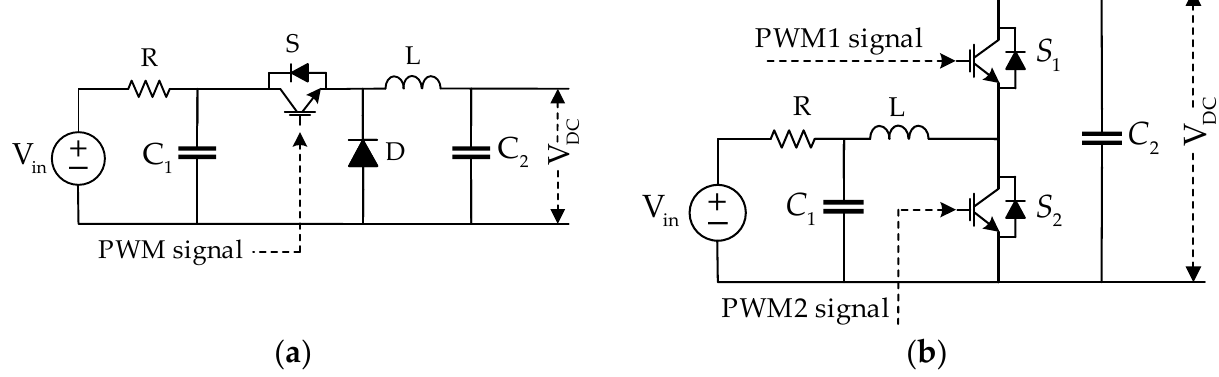
Figure 7. Structure of DC/DC converters. ( a ) Boost converter. ( b ) Buck–boost converter.